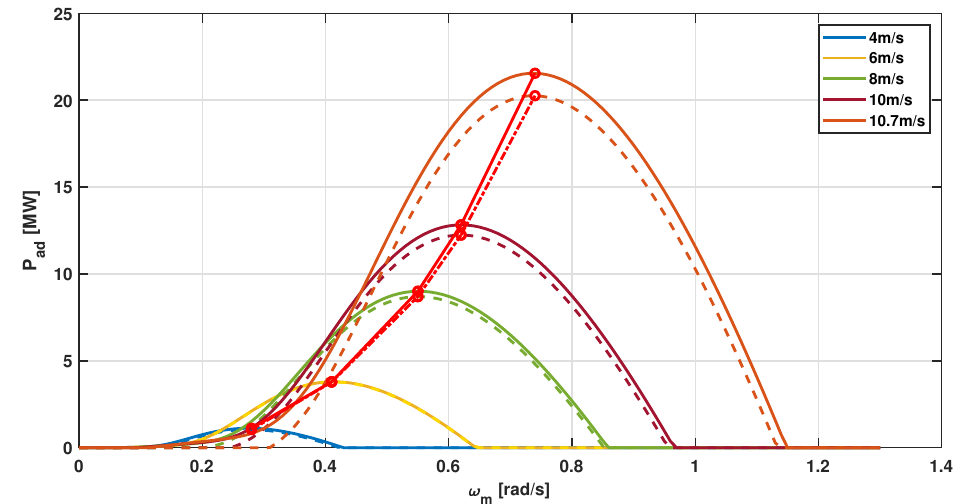
Figure 11. Analytical results of P ad − ω m corresponding to different wind velocities V m